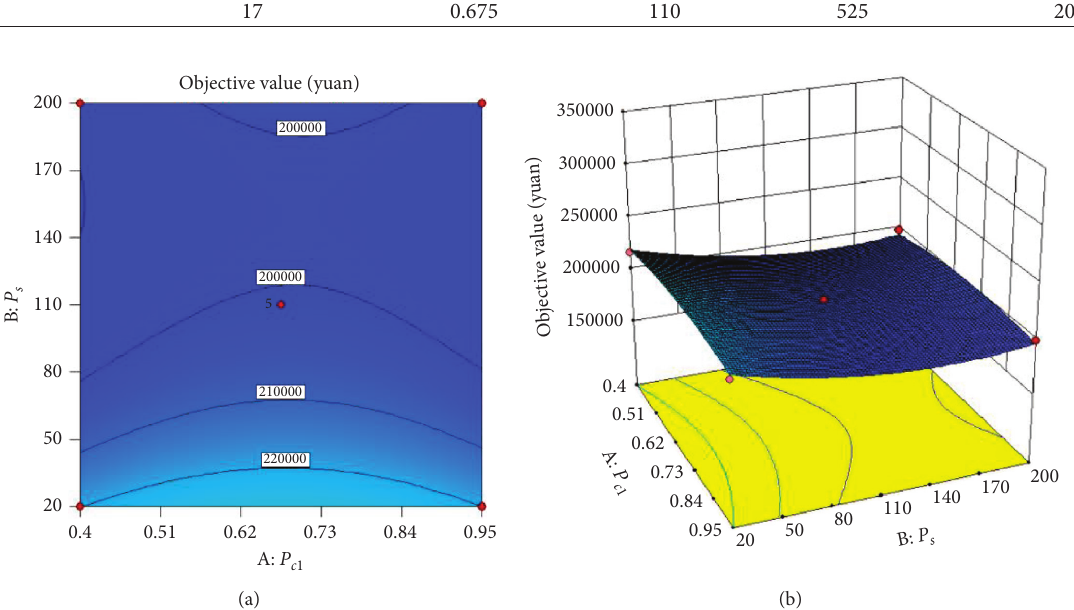
Figure 6: The response surface plot and the corresponding contour plot showing the effects of crossover rate and population size on